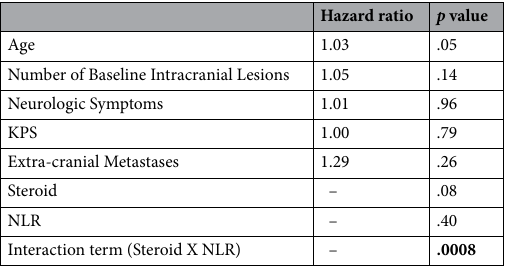
Table 2. Multivariable analysis of OS including upfront steroids, NLR and an interaction term between upfront steroids and NLR. Estimates from Cox proportional hazards models and the associations tested with effect likelihood ratio tests.